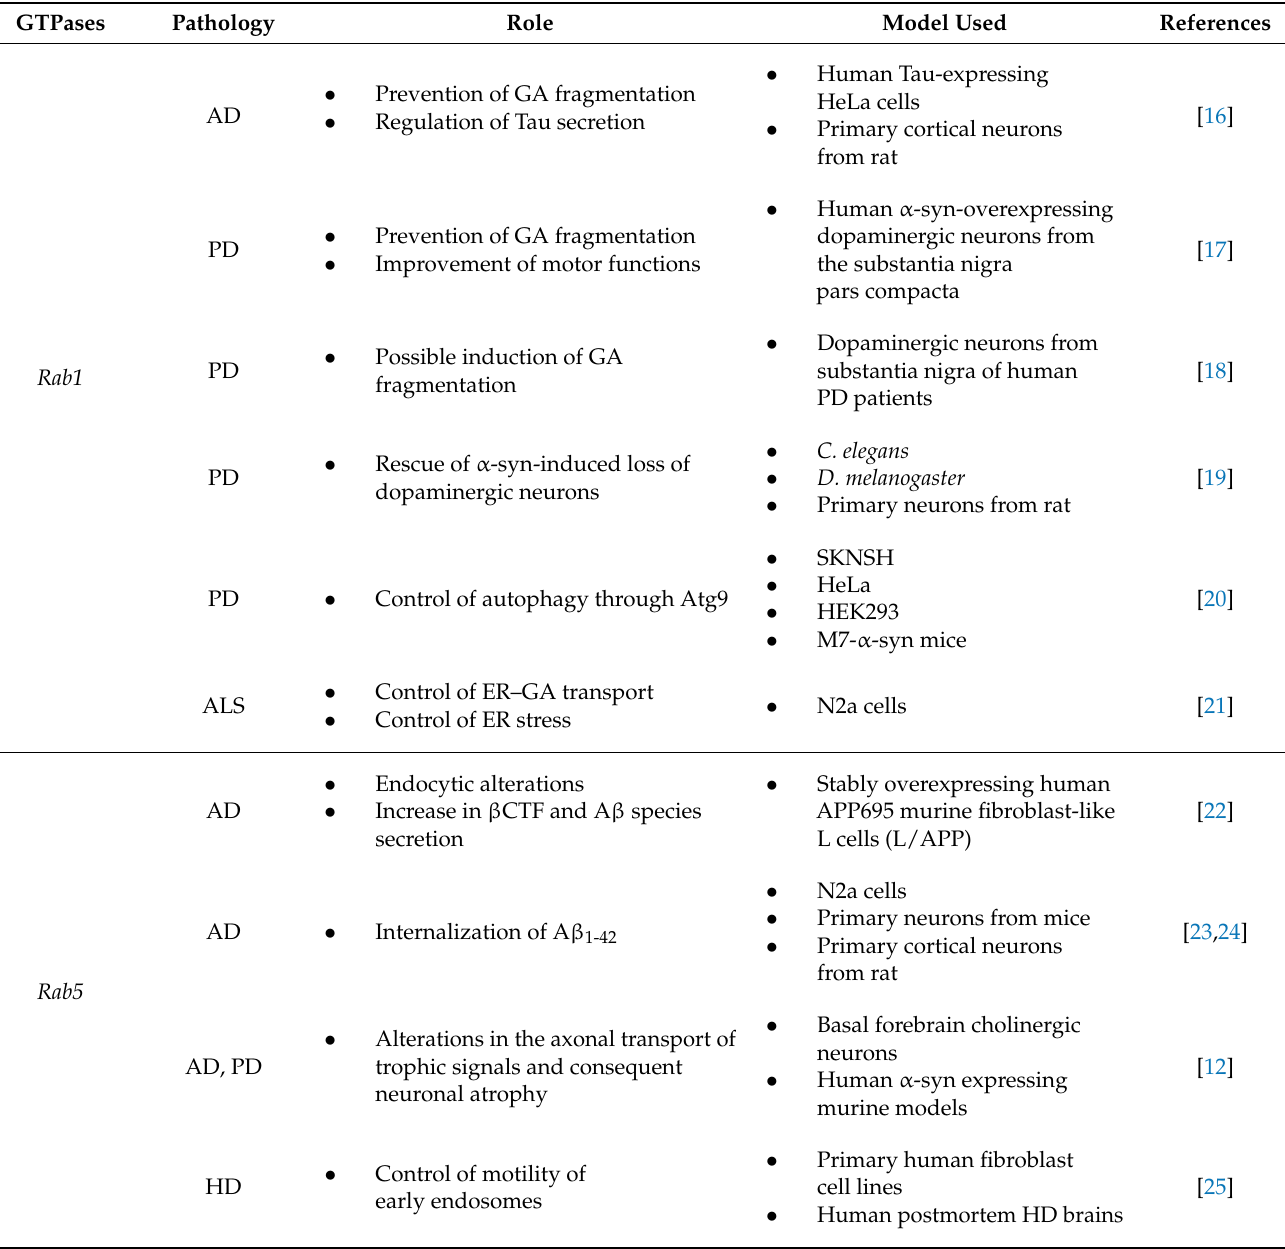
Table 1. Role of Rab and Arf GTPases in neurodegeneration. Schematic table of Rab and Arf GTPases and their described role in neurodegenerative diseases in different models. A β : amyloid- β AD: Alzheimer’s disease; ALS: amyotrophic lateral sclerosis; APP: amyloid precursor protein; α -syn: α -synuclein; β CTF: β -cleavage C-terminal fragments; CMT2B: Charcot– Marie–Tooth type 2B; ER: endoplasmic reticulum; GA: Golgi apparatus; HD: Huntingon’s disease; MS: multiple sclerosis; PD: Parkinson’s disease; TLR: toll-like receptor.